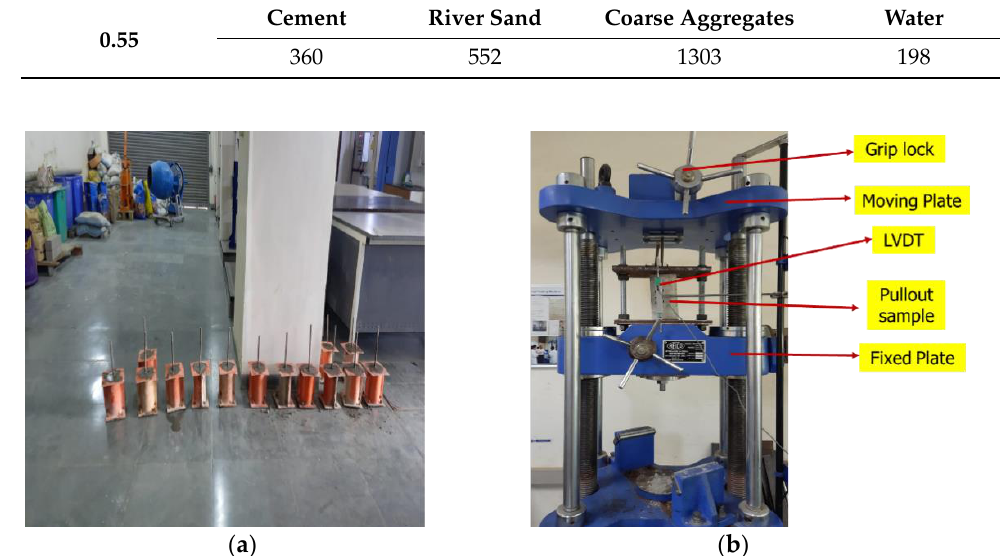
Figure 2. ( a ) Casting of cylinder specimen, ( b ) sample mount in the universal testing machine UTM.